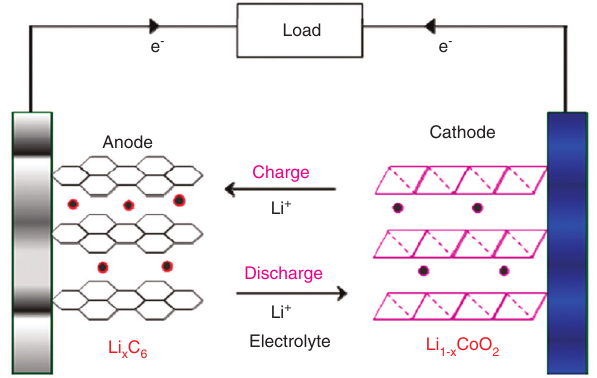
Figure 1 Schematic illustration of a typical commercial Li-ion battery. Reprinted with permission from Ref. [7]. © 2011 American Chemical